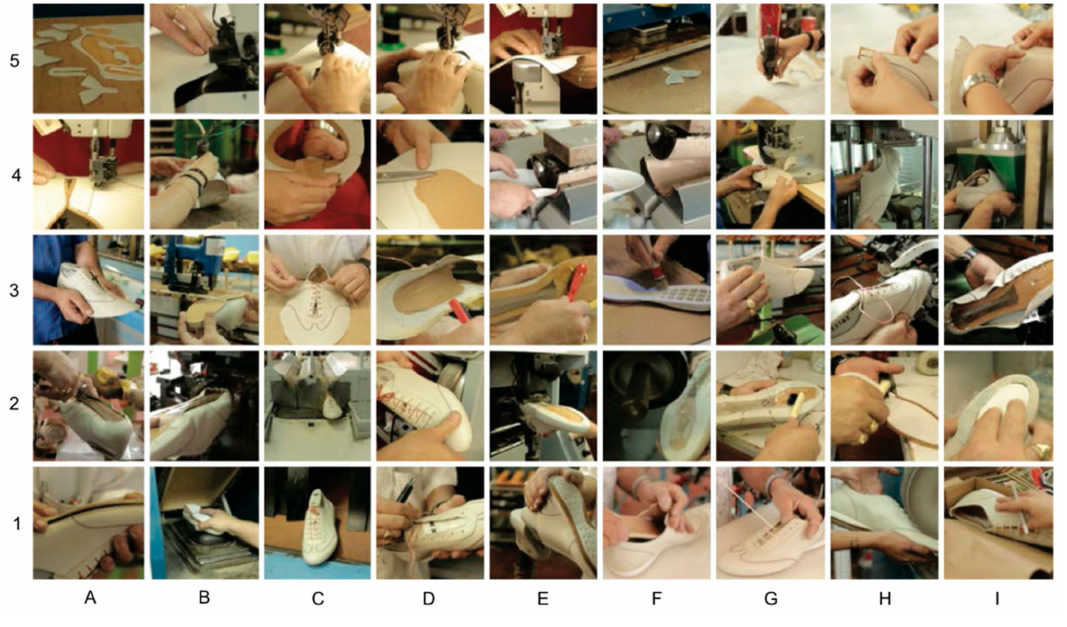
Figure 1. Steps to produce a pair of shoes. Courtesy of Simplicity Works Europe.